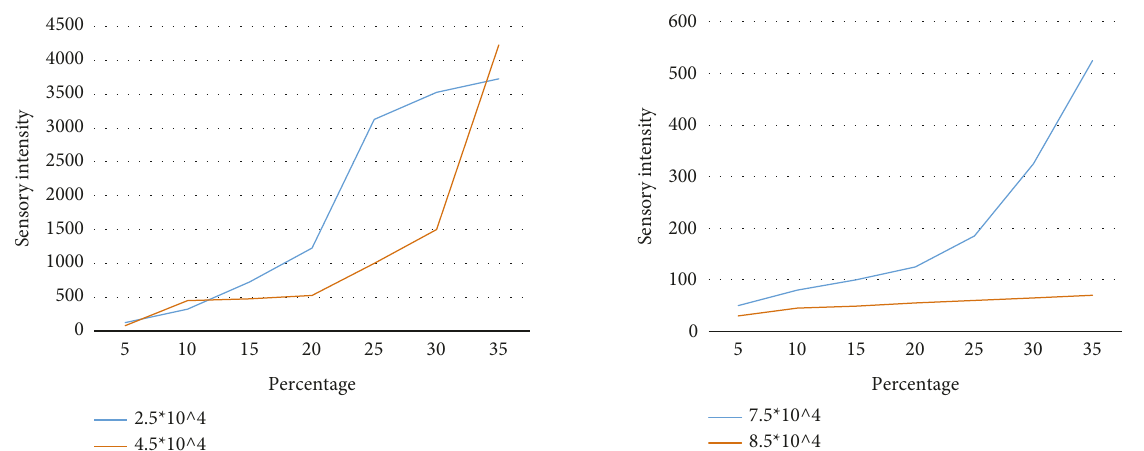
Figure 10: Efficiency of optoelectronic devices with different concentrations of nanomaterials.